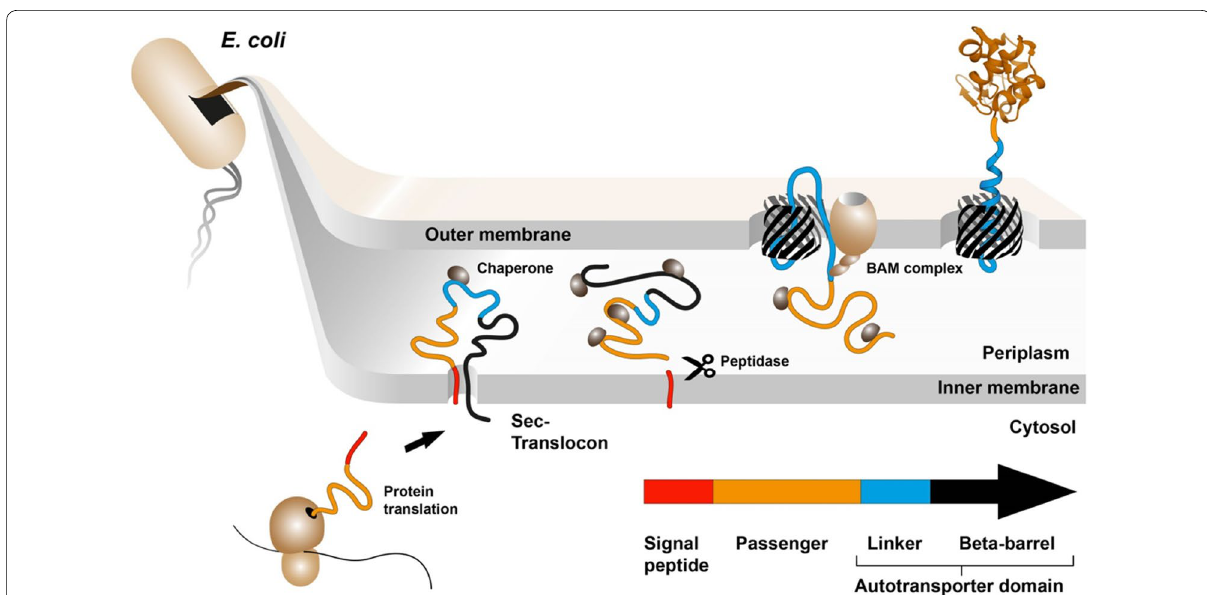
Fig. 5 The hypothetical model of the autodisplay secretion mechanism. The transport protein (e.g., enzyme) translates from the cytosol through the inner membrane, where the signal peptide is cleaved off by specific peptidases. The autotransporter and the passenger enzyme move across the outer membrane for outward exposure. The β-barrel helps in anchoring the passenger onto the surface of the bacteria whereas the linker enforces the outward exposure of the passenger [The figure was adapted from Tozakidis et al.